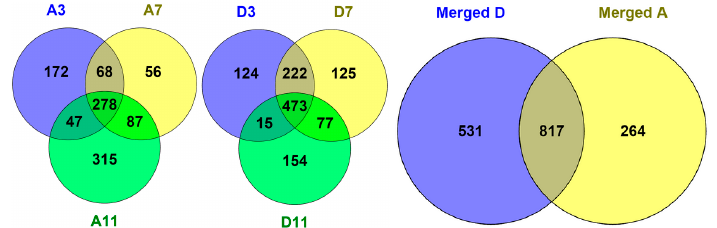
Figure 7. Venn diagrams representing the overlapping of identified proteins between fractions generated by pH-tuned ND fractionation of both aqueous phase (A) and detergent phase (D) at three pH values (pH11, pH7, and pH3).